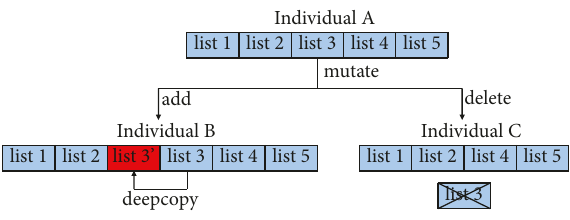
Figure 10: Schematic diagram of layer mutation of ECNN.